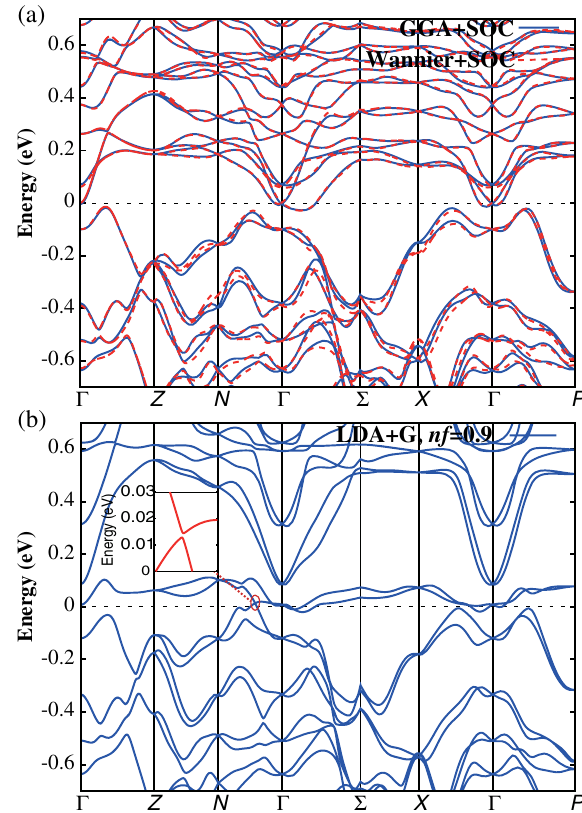
FIG. 2. (a) The band structure of CeRu 4 Sn 6 calculated by GGA þ SOC (solid line) and Wannier þ SOC (dashed line). (b) The renormalized band structure of CeRu 4 Sn 6 calculated by the LDA þ Gutzwiller method. The Fermi energy is set to 0 eV. The gap of the bands in the inset is about 1.5 meV, which indicates that a zero gap Weyl point exists